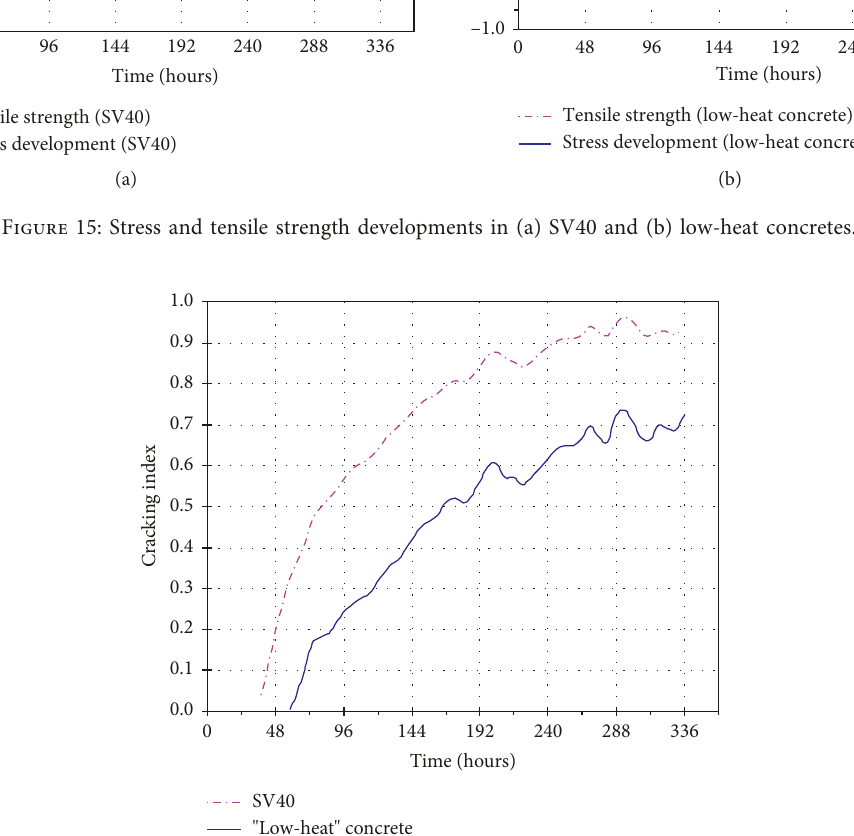
SV40 Figure 16: Cracking index in SV40 and low-heat concretes. Table 6: Maximum stress and cracking risk index. Tensile stress Concrete